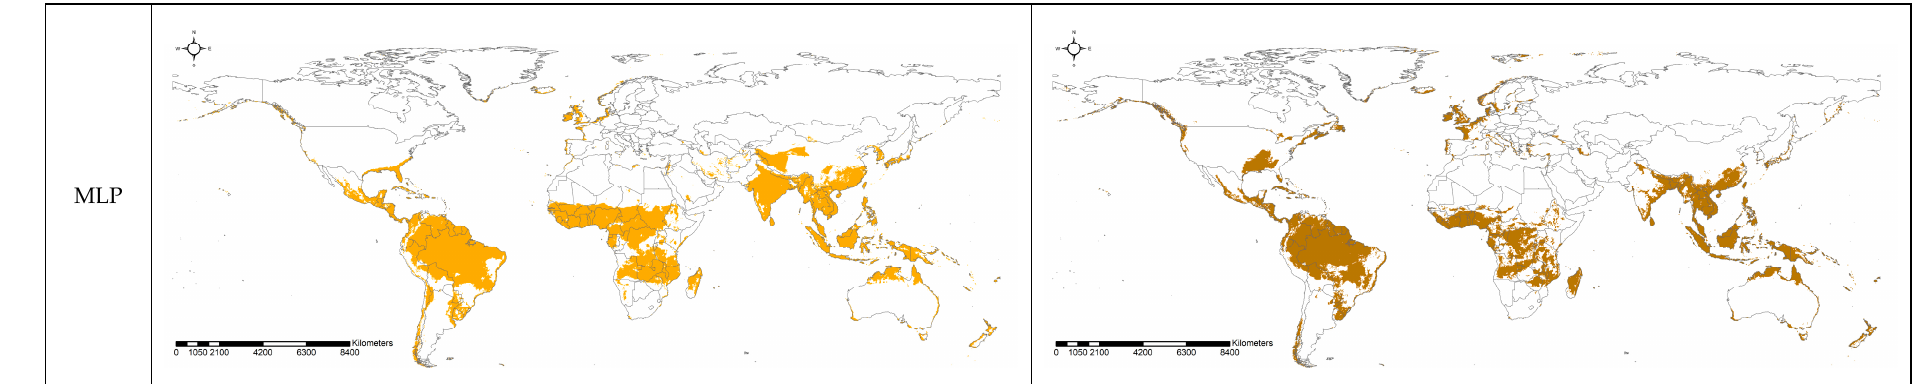
Figure 3. Classification of potential presence and absence areas for A. gracilipes by each model and climate change scenario.